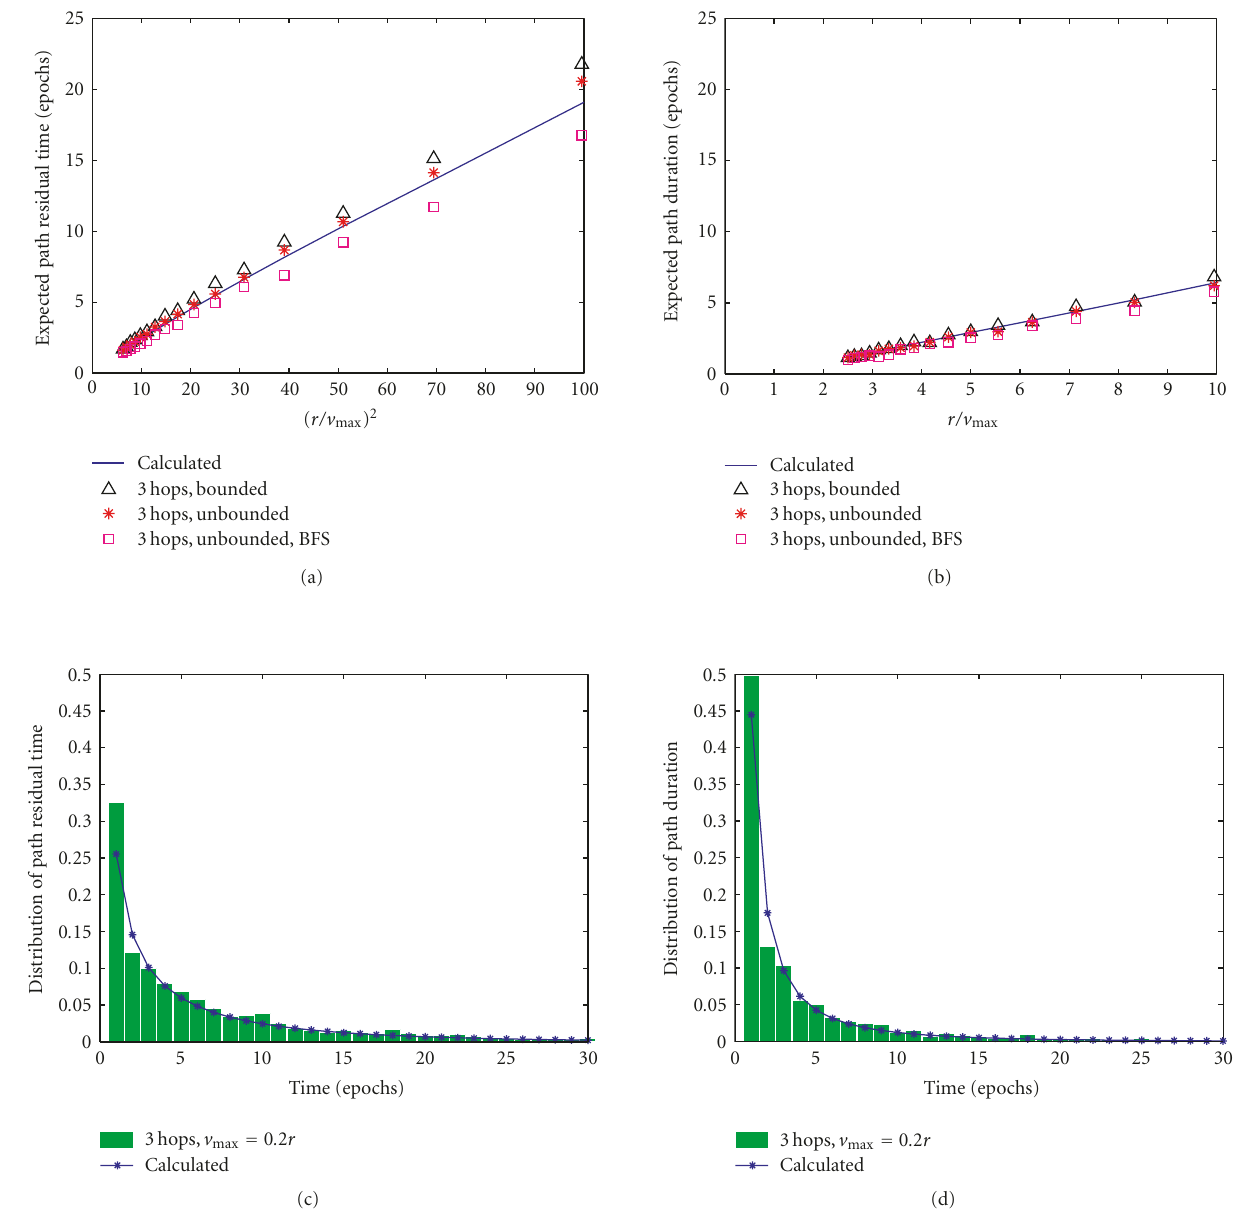
Figure 8: Comparison of metric calculations and simulated results for path residual time and path duration. Each MN moves at a randomly chosen velocity during each epoch, which has uniformly distributed speed in the range [0, v max ] and uniformly distributed direction in the range [0,2 π ). (a) Comparison of calculated and experimental average path residual time values for bounded and unbounded simulation areas and BFS algorithm. Calculated values are from (40). (b) Comparison of calculated and experimental average path duration values for bounded and unbounded simulation areas and BFS algorithm. Calculated values are from (42). (c) Comparison of calculated and ex- perimental distributions of the path residual time for an unbounded simulation area. Calculated values are from (39). (d) Comparison of calculated and experimental distributions of the path duration for an unbounded simulation area. Calculated values are from